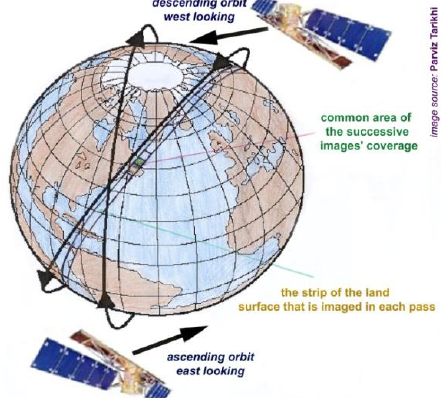
Figure 2: Concept of ascending and descending orbits In practice SAR satellite observes obliquely downward (off nadir) and not directly below (nadir). Therefore, when it is in ascending orbit (northward) the satellite observes from west and in descending orbit (southward) the satellite observes from east (Figure 2). In case of the westward movement of the surface, if satellite observes in ascending orbit (northward), the surface moves near to the satellite. Contrarily, if satellite observes in descending orbit (southward), the ground moves far from the satellite. That is why the ascending and descending SAR images of the same area looks